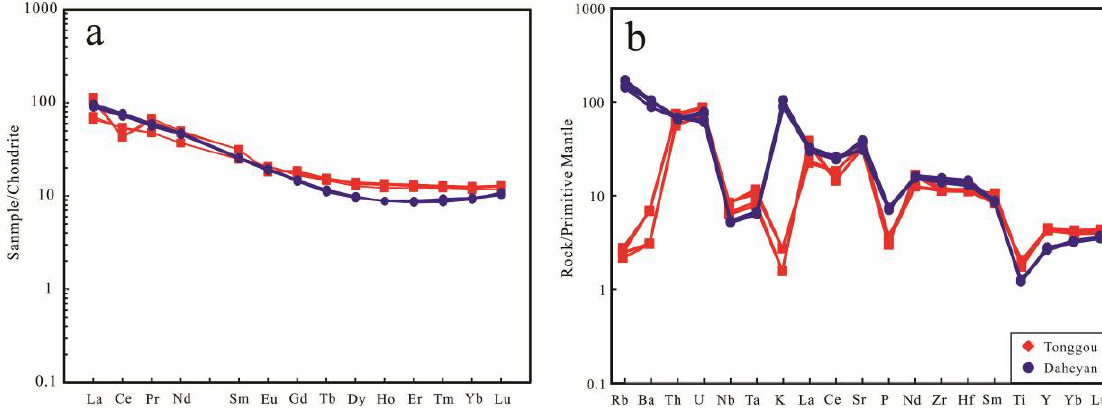
Figure 7. (a) Chondrite-normalized REE pattern; (b) primitive-mantle-normalized spider diagrams from whole rocks analyses. Chondrite and primitive mantle values used for normalization are from [67] and [68], respectively. Partial data for Daheyan granodiorite cited from [51].